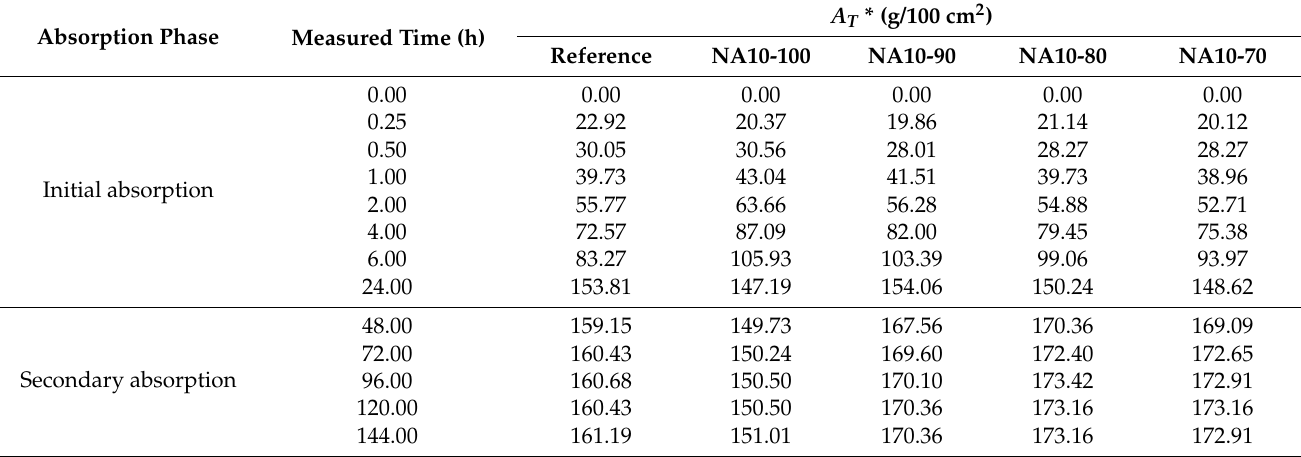
Table 2. Water absorption rate of the sample containing the optimum concentration of nano-Al 2 O 3 particles (10%) and different contents of fly ash